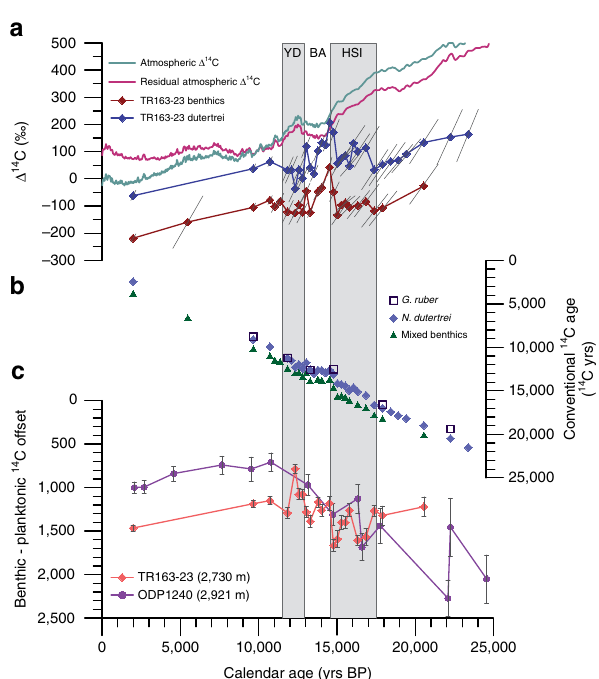
simultaneous 14 C depletions in EEP deep and thermocline waters indicate that the EUC likely transported carbon to upwelling zones in the Eastern Pacific, much as it does at present. Indeed,